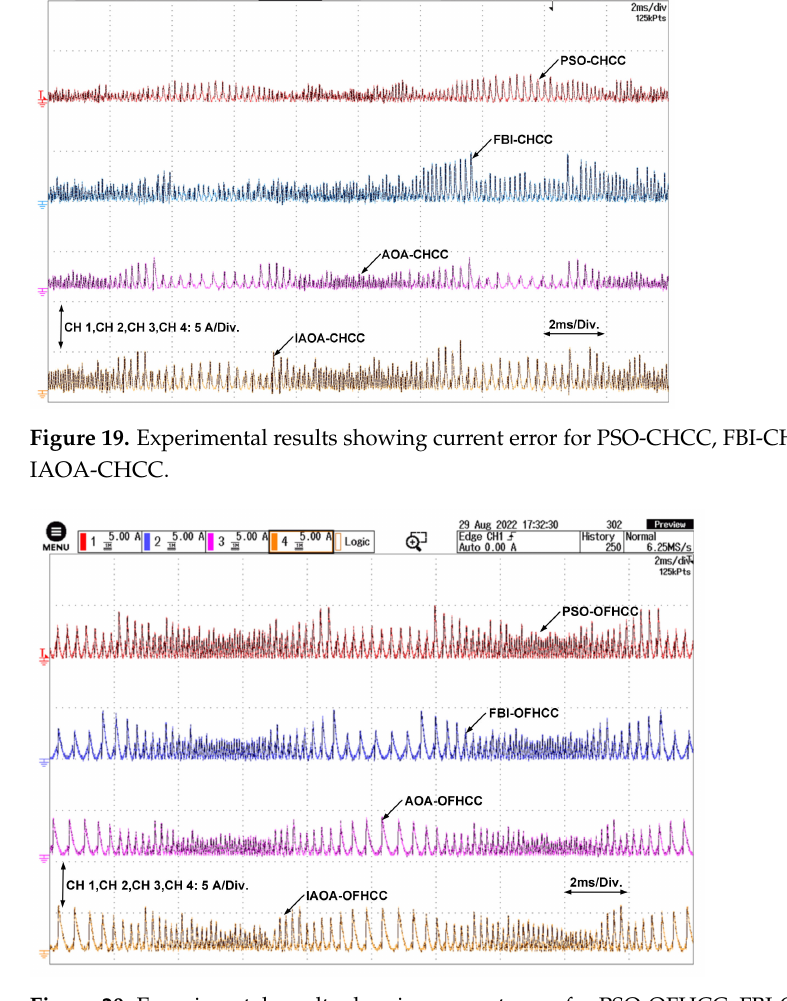
Figure 20. Experimental results showing current error for PSO-OFHCC, FBI-OFHCC, AOA-OFHCC, and